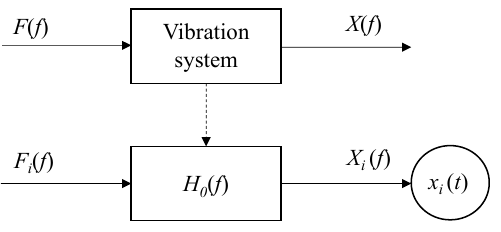
Figure 3. Prediction process when input and output don’t contain noise.